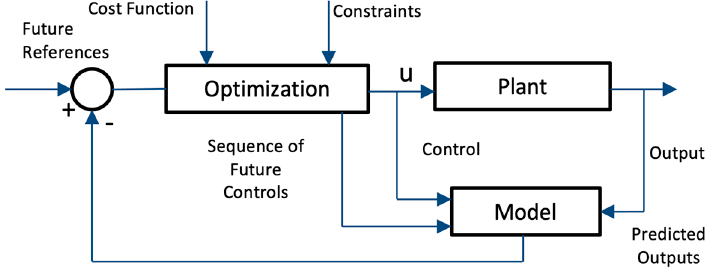
Figure 6. Model of a predictive control [62].